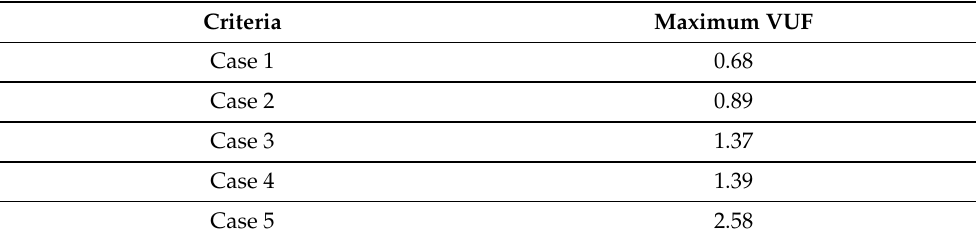
Table 4. Maximum VUF before using the proposed volt/var control